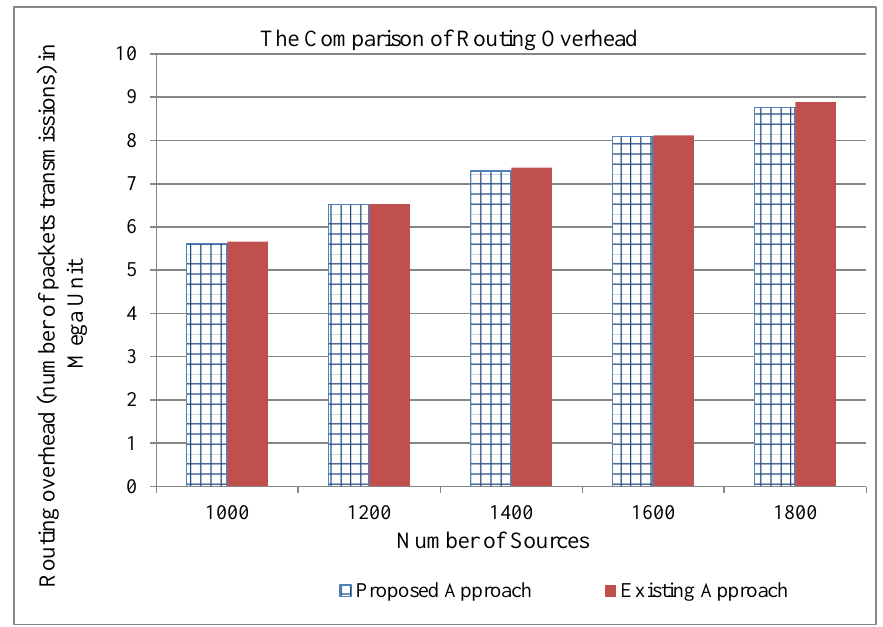
Figure 5. The comparison of traffic overhead of the existing and proposed approaches for two cache servers.